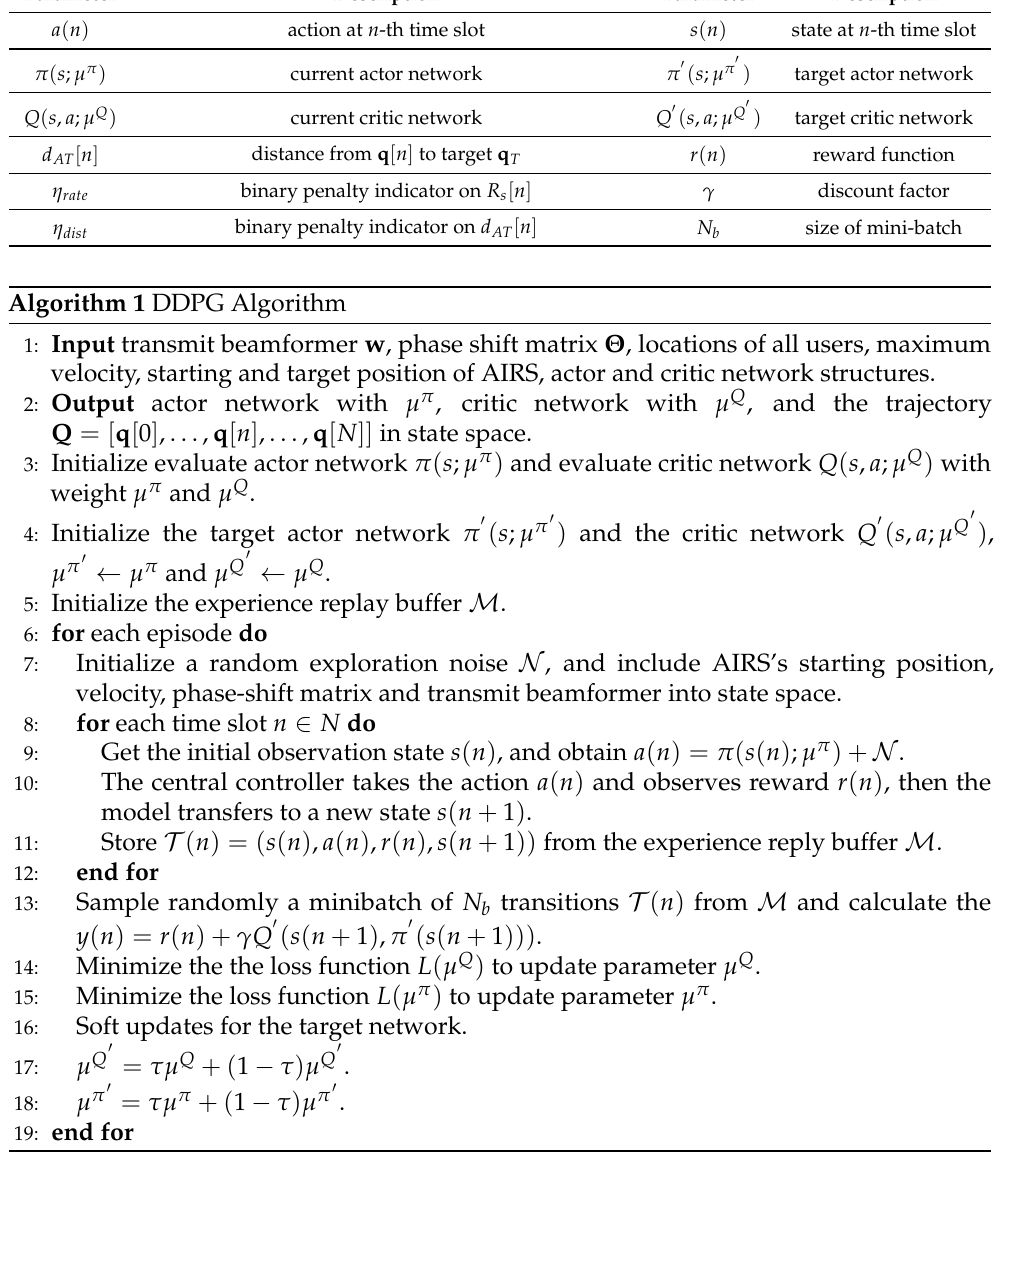
Table 3. Notations for parameters used in the neural network.